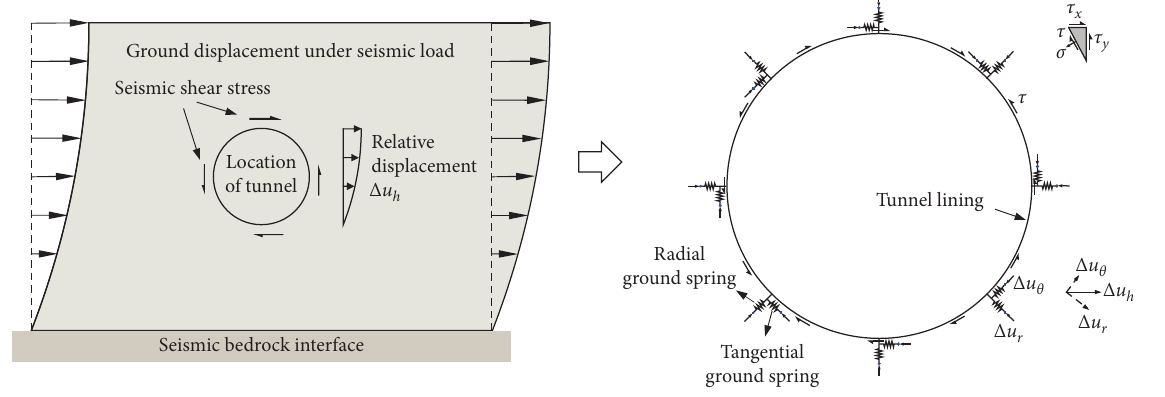
Figure 1: Response displacement method.